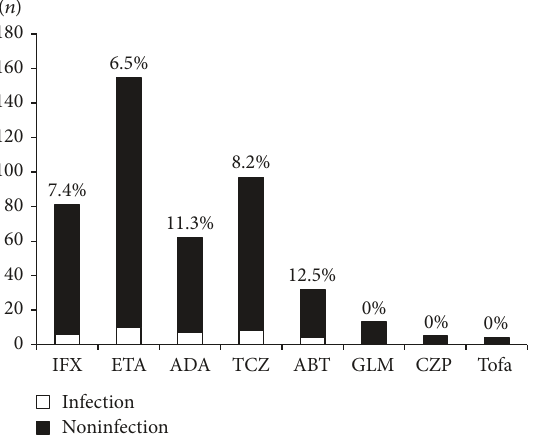
Figure 1: The number and percentage of hospitalized infections during the treatment with each biological disease-modifying antirheumatic drug (bDMARD)/targeted synthetic disease-